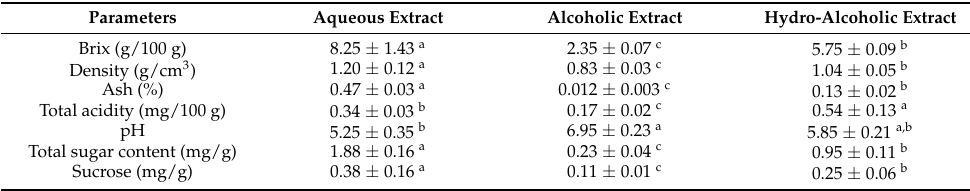
Table 1. Compositional differences of oleaster ( E. angustifolia )